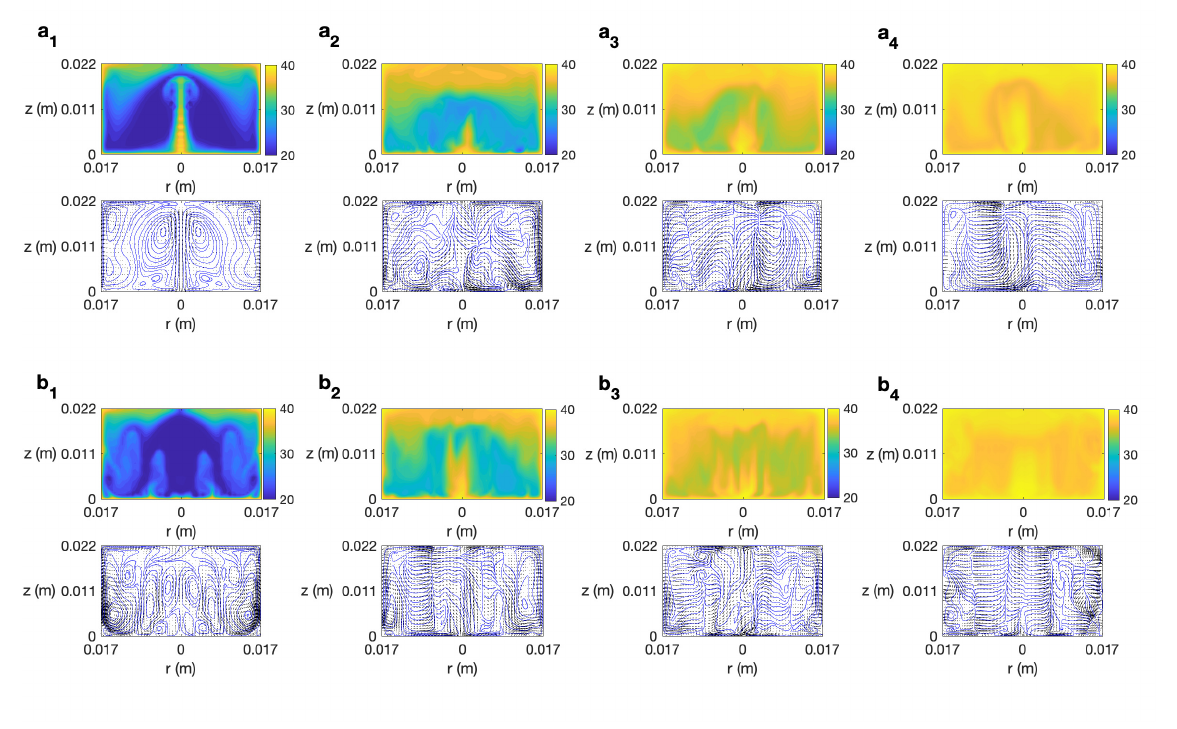
Figure 6. Contour of the predicted temperature, velocity field and streamlines in the r − z plane at φ = 0 ( φ = π ) for T e = 40 ◦ C. ( a ) Ω = π s − 1 . ( a 1 ) t = 10 s; ( a 2 ) t = 30 s; ( a 3 ) t = 50 s; ( a 4 ) t = 70 s; 100 ( b ) Ω = π s − 1 . ( b 1 ) t = 10 s; ( b 2 ) t = 30 s; ( b 3 ) t = 50 s; ( b 4 ) t = 70 s. 60